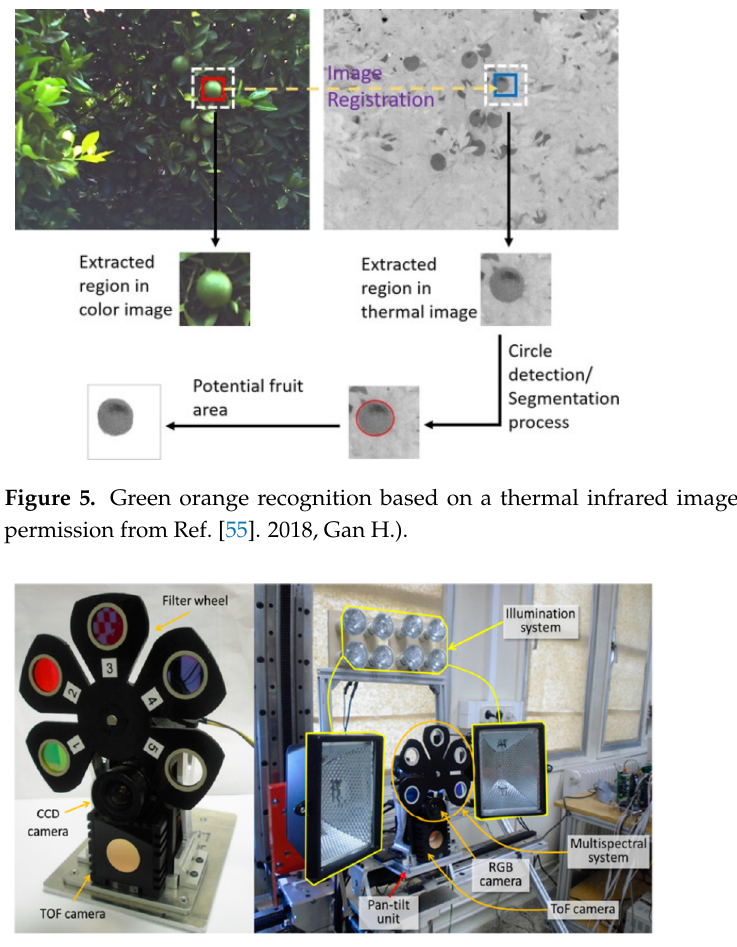
6 of 20 Figure 4. Color correction from multi-exposure images (Photo: Reprinted with permission from Ref. [53]. 2020, Feng Q.). ( a ) Multi-exposure images; ( b ) radiation intensity estimation; and ( c ) image color recovery. 3.2. Similar-Colored Target Image Acquisition When the picking objects are cucumber, pepper, green orange, and so on, the fruit has a similar color to the plant stems and leaves. It is not easy to accurately recognize fruit